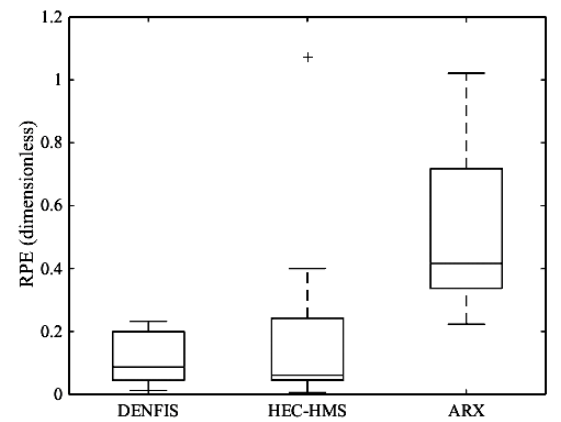
Figure 5. Comparison of RPE values for peak discharge of 18 testing events simulated by DENFIS and HEC–HMS models in Sungai Kayu Ara catchment.